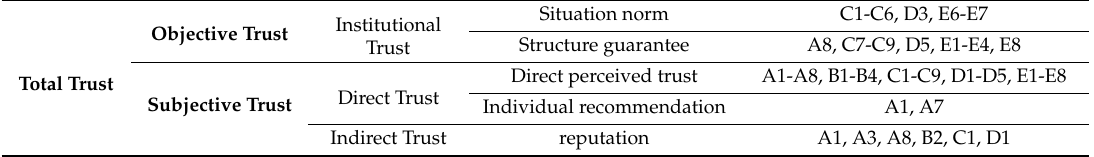
Table 2. Hierarchical structure of online trust in BtoC e-commerce.